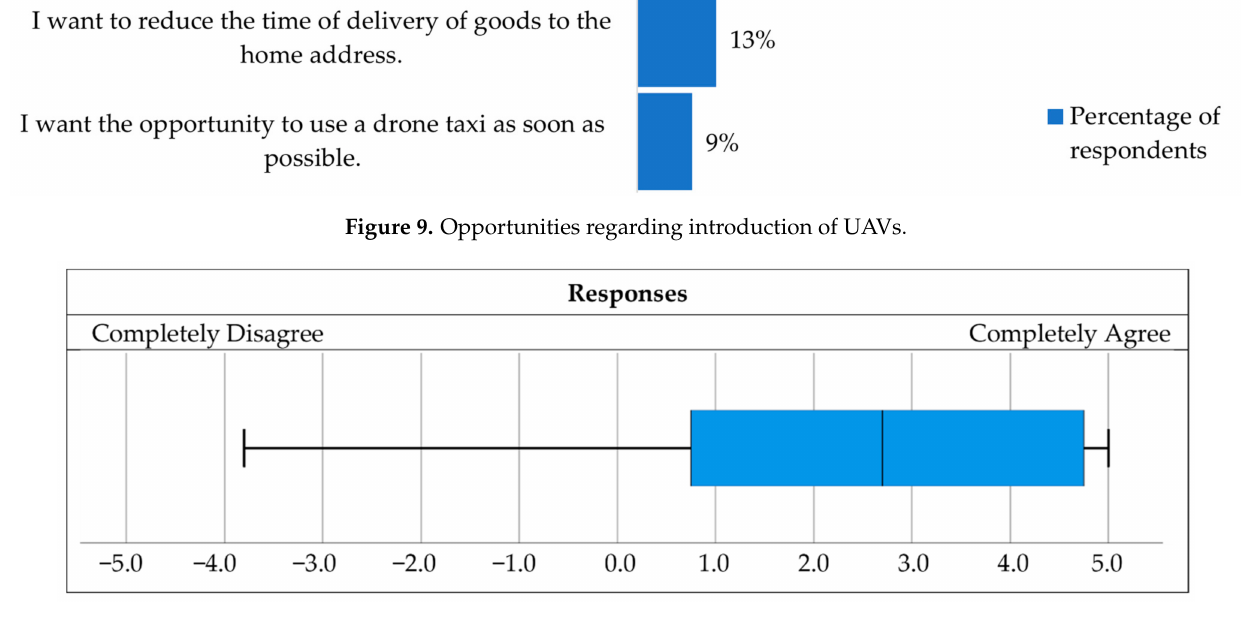
Figure 10. The benefits vs. negative impacts of